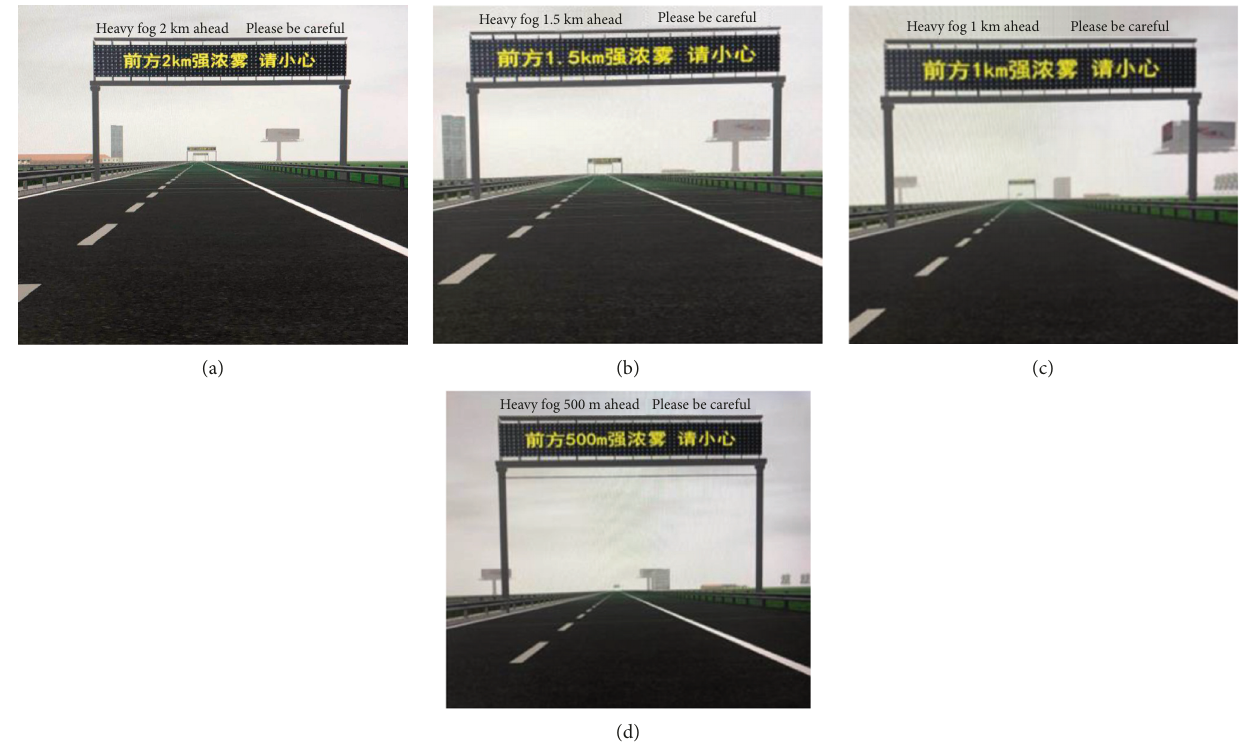
Figure 3: DMS design (a) DMS1. (b) DMS2. (c) DMS3. (d)